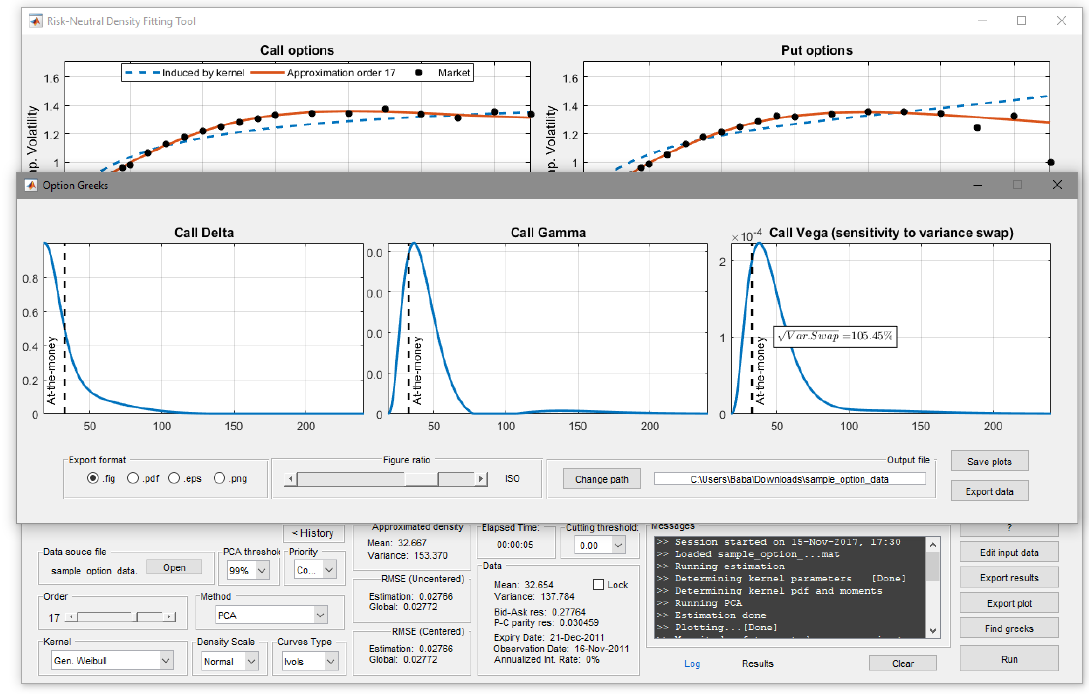
Figure 5. Greeks obtained with a GIG kernel and expansion order n = 18 with 5 PCA